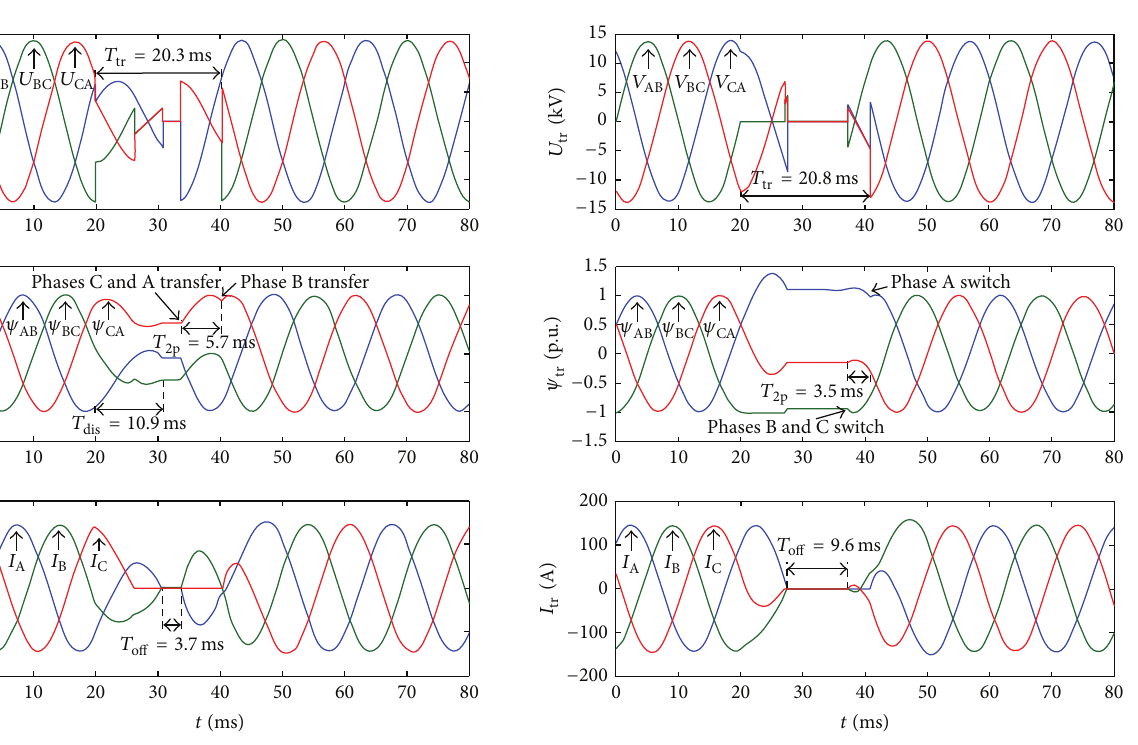
Figure 11: Waves of the transfer strategy with flux linkage DC component elimination (three-phase voltage sag). From the top to bottom, they are transformer voltages, transformer flux linkages, and load currents.